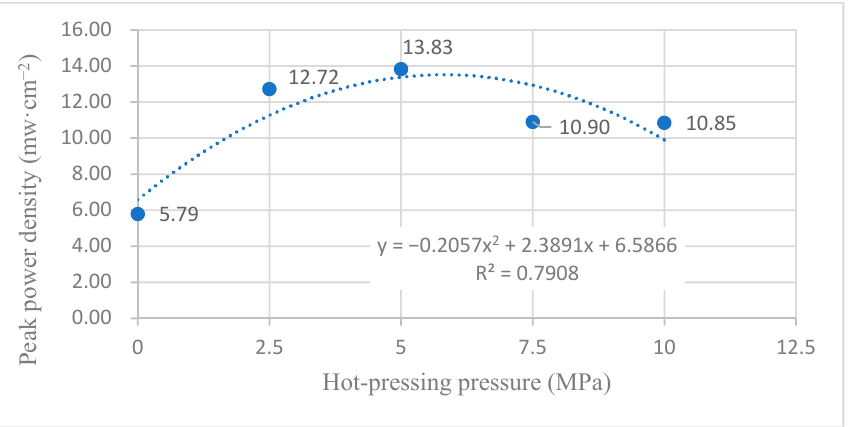
Figure 22. The fitting curve of the peak power density of MEA at different hot-pressing pressures under 60 °C and oxygen conditions.